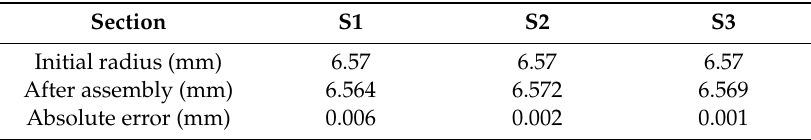
Table 2. Curvature radii at the separated arc segments after interference